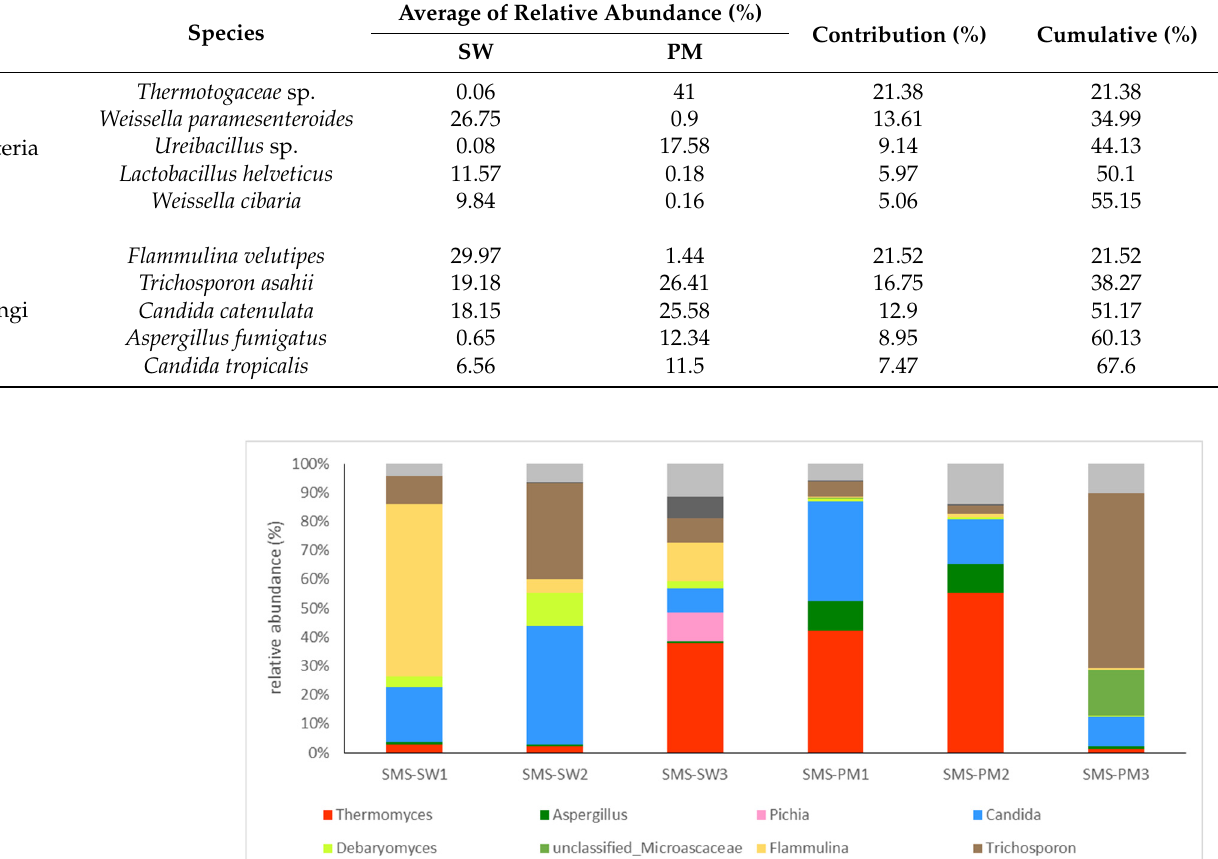
Table 2. Similarity percentage (SIMPER) analysis showing the five most influential species that con- tribute to the difference in the bacterial or fungal community structure between the spent mushroom substrate with addition of soy wastes (SMS-SW) and swine and poultry manure (SMS-PM).